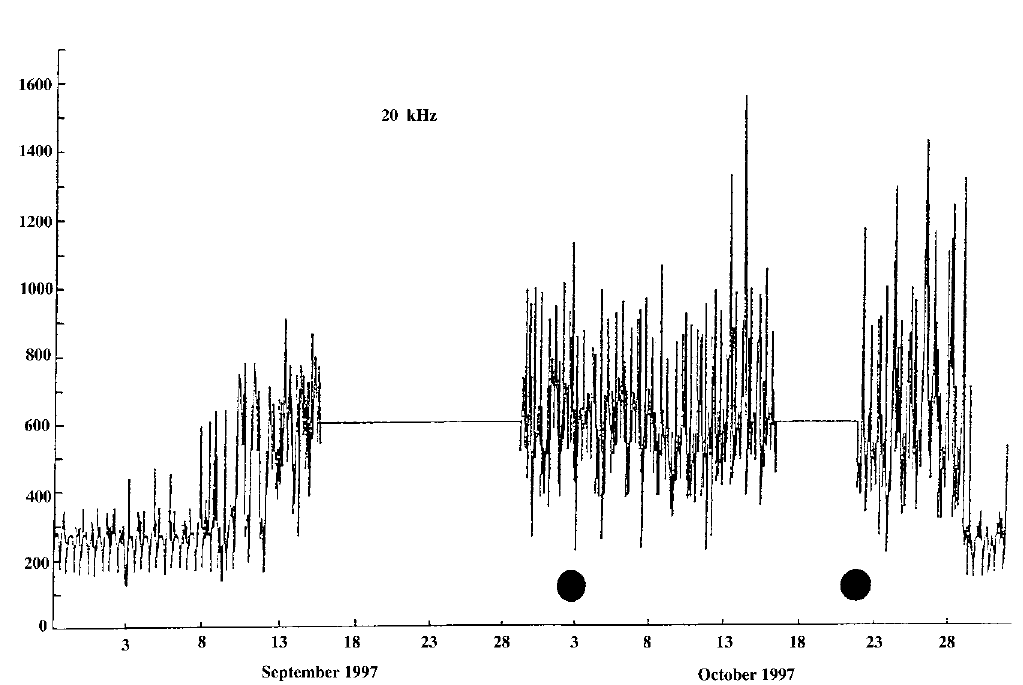
Fig. 3. VLF/recording (20 kHz) of radio-noise at L’Aquila Observatory (after Meloni et al ., 2001, and Ernst et al ., 2001): September and October, 1997; two greater seismic events with M (cid:53) 5 are marked by the black circles, straight intervals correspond to the gaps of